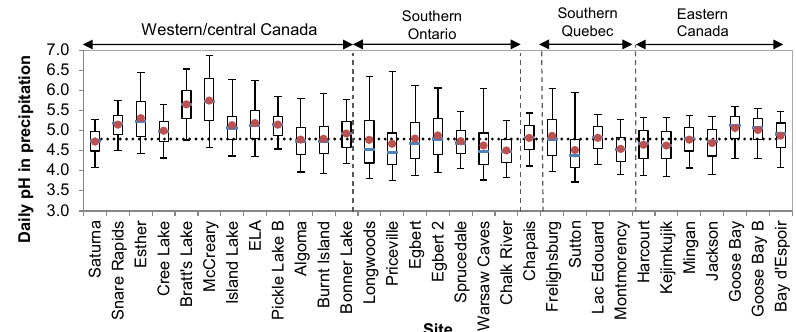
Figure 8. Geographical patterns of precipitation pH. See Fig. 6